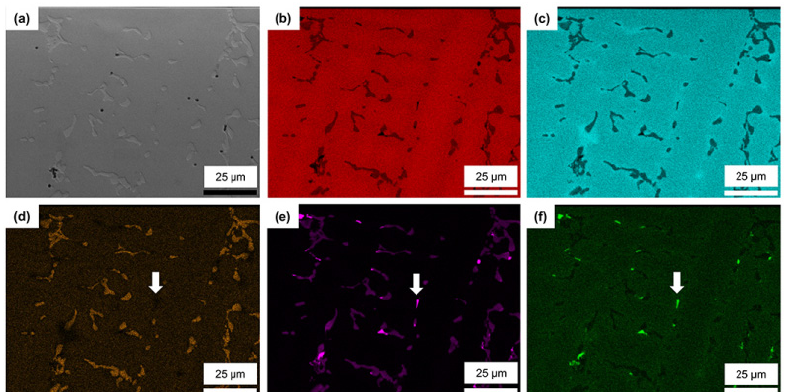
Figure 3. Scanning electron microscopy (SEM) micrographs of the mirror-polished as-cast Co–Cr alloy ( a ) and its energy-dispersive X-ray spectroscopy (EDS) mapping images ( b – f ): ( b ) Co; ( c ) Cr; ( d ) W; ( e ) Nb; and ( f ) V. Nb and V-based precipitates without W (arrow in ( d )) were observed as another secondary phase (arrows in ( e ) and ( f )).